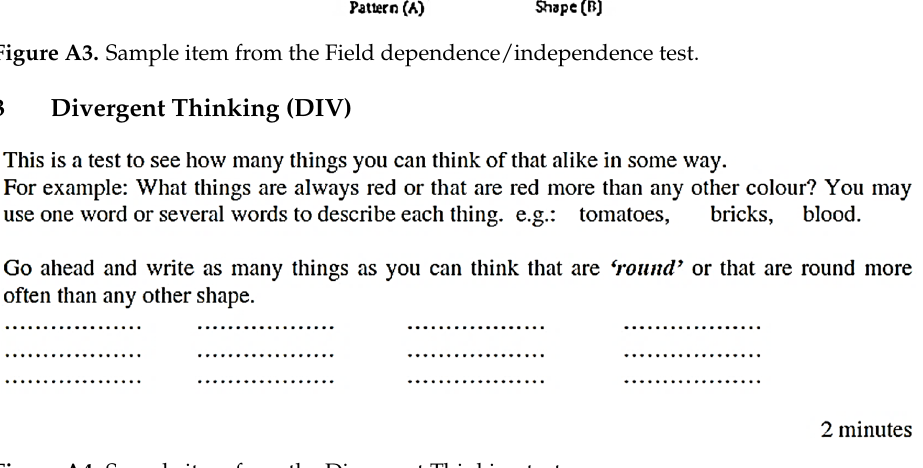
Figure A4. Sample item from the Divergent Thinking test.